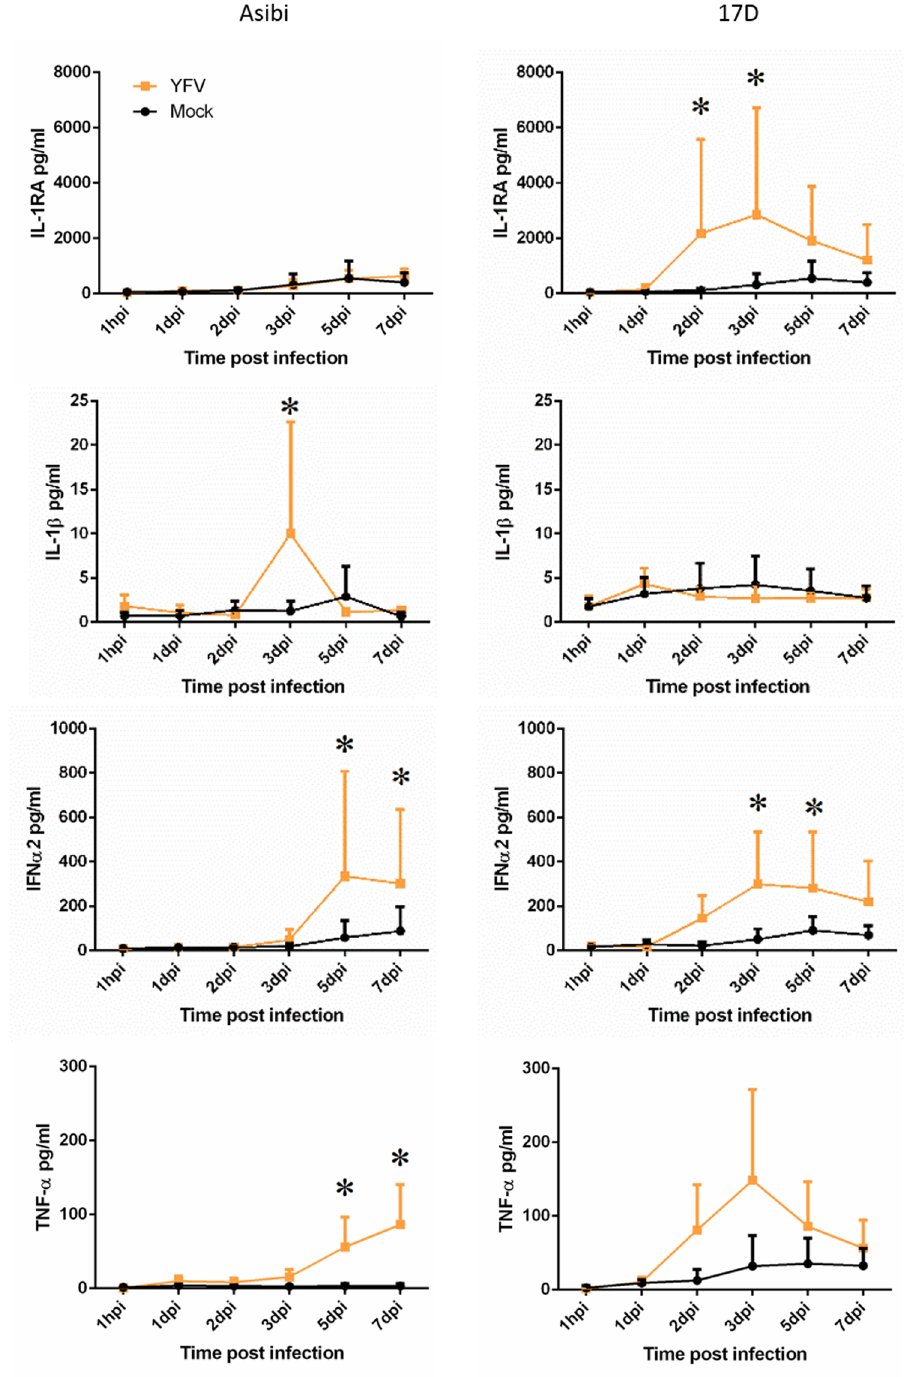
Fig 3. Cytokine response in human MDM. Cytokine response in human MDM infected with either wild-type Asibi virus or the vaccine strain 17D virus (yellow) in relation to mock (black) infected cells. All data points represent triplicate biological replicates. ( * ) indicates points of significant (p < 0.05) difference between virus and mock infected cells. Repeated measures ANOVA run in SAS was used to determine statistical